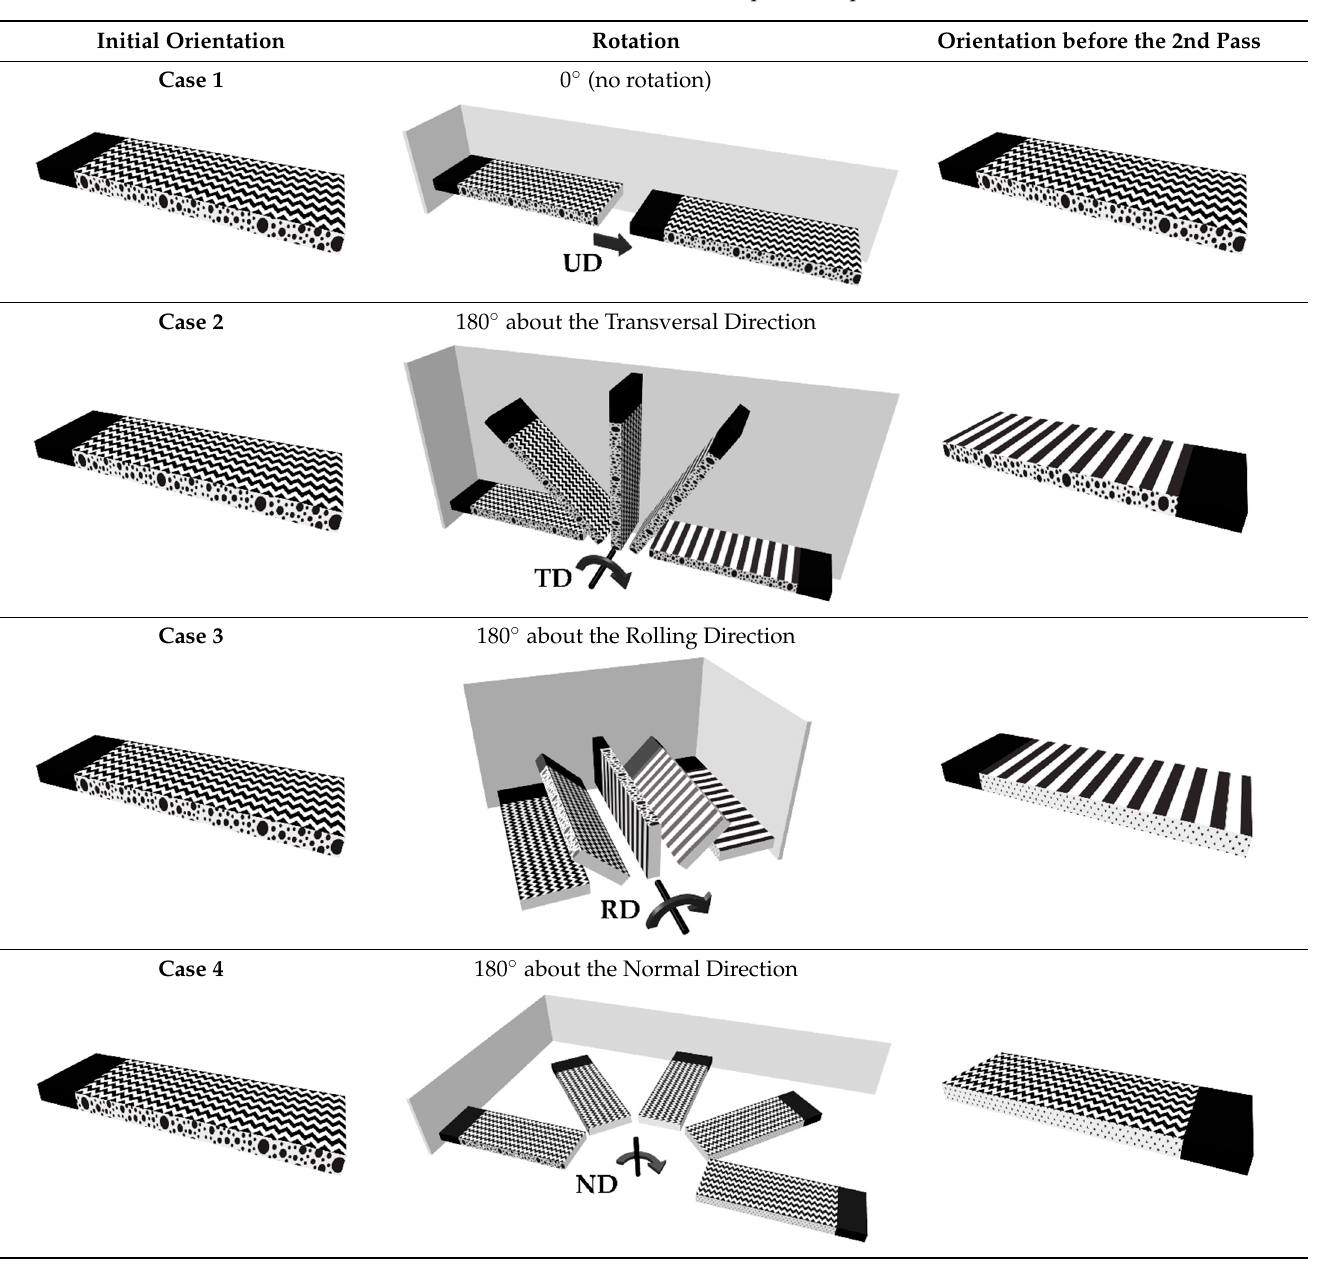
Table 3. Deformation routes in a two-pass ASR process.